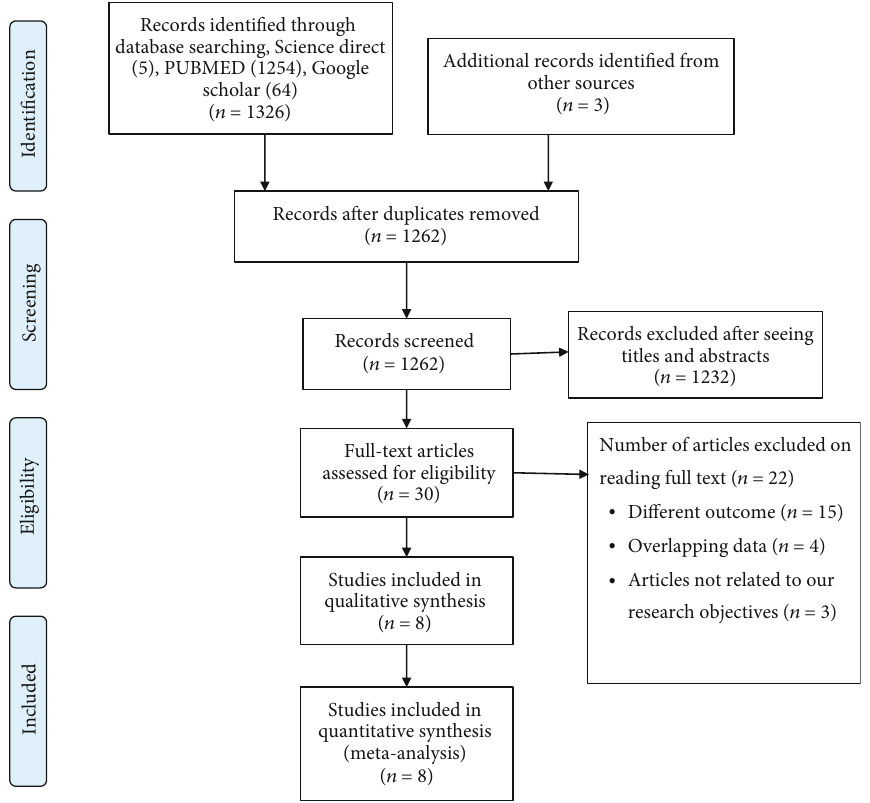
Figure 1: PRISMA fl ow chart showing the selection of primary studies. Table 1: Descriptive characteristics of 8 studies included in the systematic review and meta-analysis of e ff ect of poor social support on depression among HIV patients in Ethiopia,